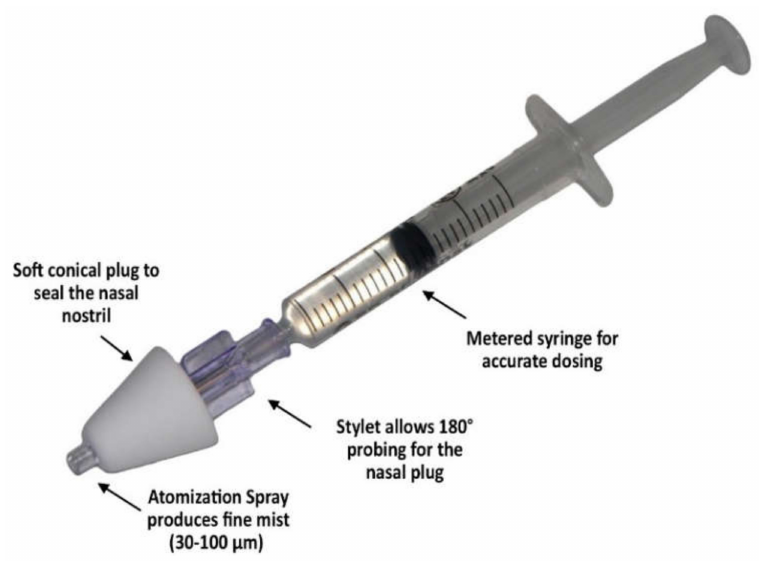
Figure 7. The Mucosal Atomizer Device (MAD) used to deliver medications via a fine spray in the nasal cavity. Reproduced from [111], Springer Nature,